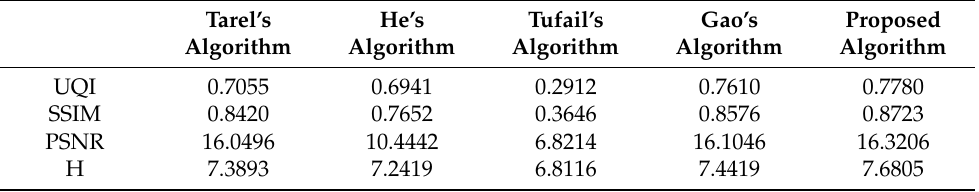
Table 3. Objective evaluation results on the third group of defogged images based on five defogging